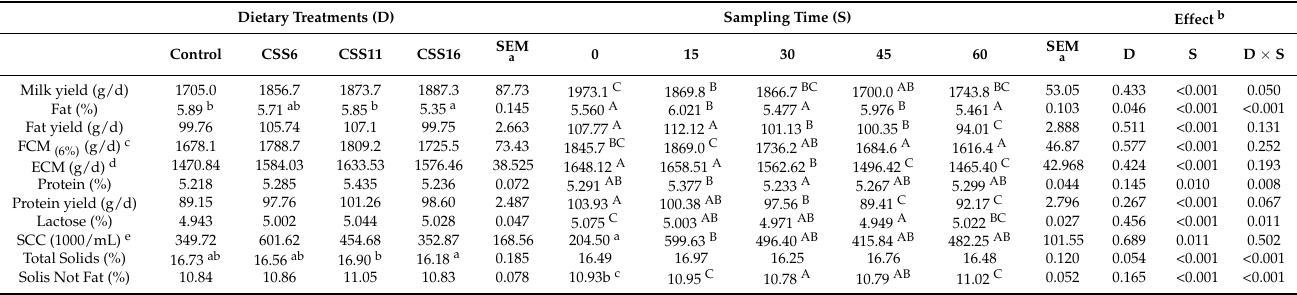
Means with different superscript letters (a, b, c) between dietary groups and (A, B, C, D) between sampling time points differ significantly. a SEM: Standard error of the means. b Effect: The dietary treatment (D), time (S), and the interaction between dietary treatment × time (D × S) effects were analyzed by ANOVA using a general linear model (GLM) for repeated measures, and post-hoc analysis was performed with appropriate use of Tukey’s multiple range test. c Fat corrected milk (FCM) in 6%, d Energy corrected milk (ECM) yield, e Somatic Cell